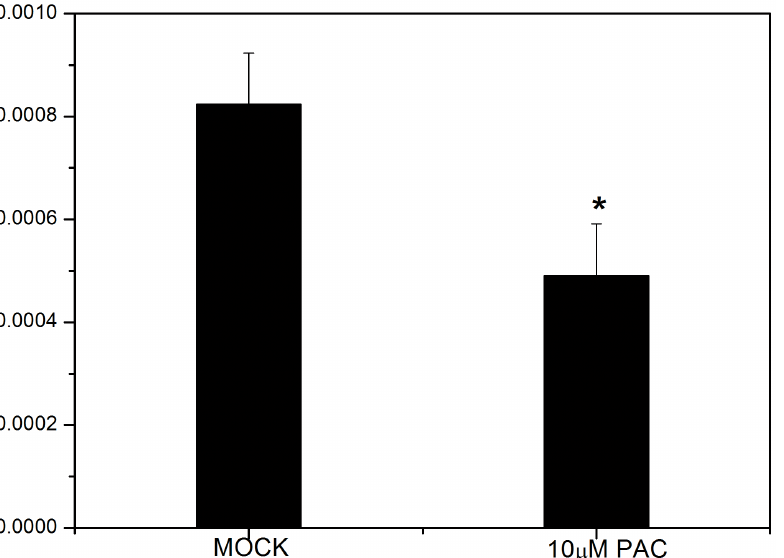
Figure 5. Expression of AtEXP2 in response to paclobutrazol treatment. AtEXP2 expression was determined by quantitative real-time RT-PCR in 24 h imbibed seeds treated with 10 m M PAC or without (Mock). Error bars represent SD. A Student’s t-test was calculated at the probability of 5% (*P , 0.05).